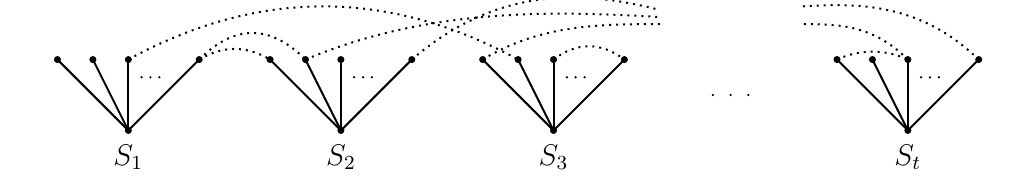
Figure 1: An illustration of a special k -star t